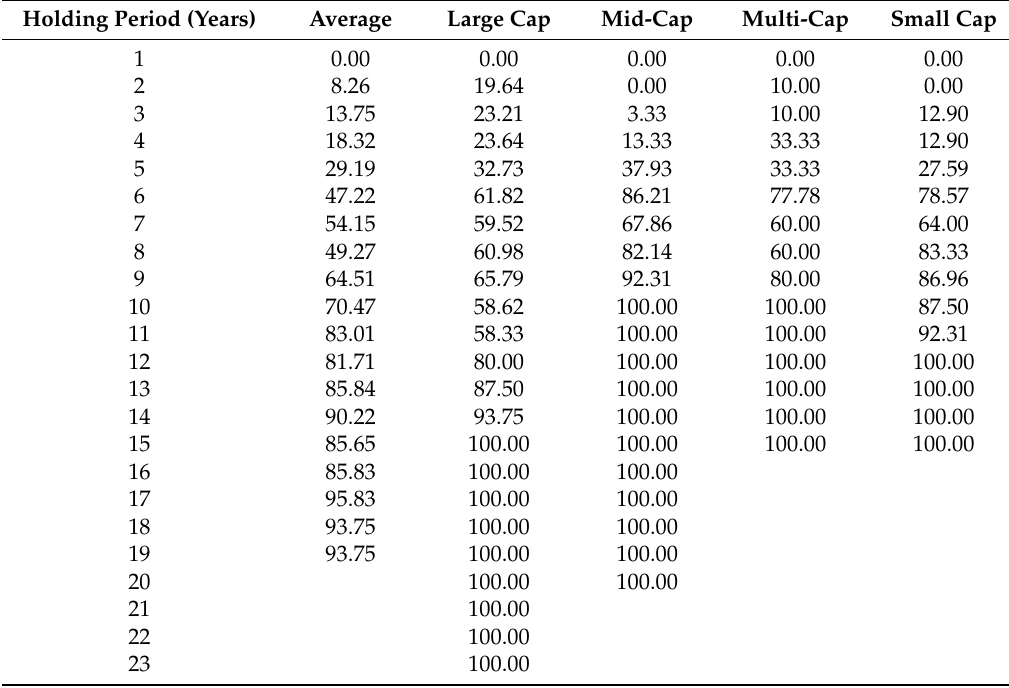
Table 7. NASDAQ Probability of No Loss by Sector (In